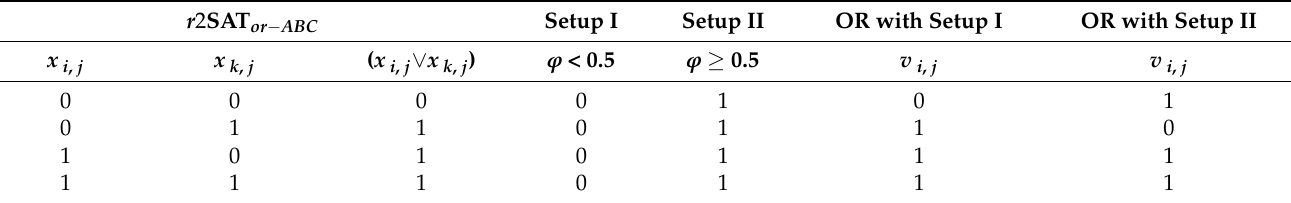
Table 8. The implication truth table for